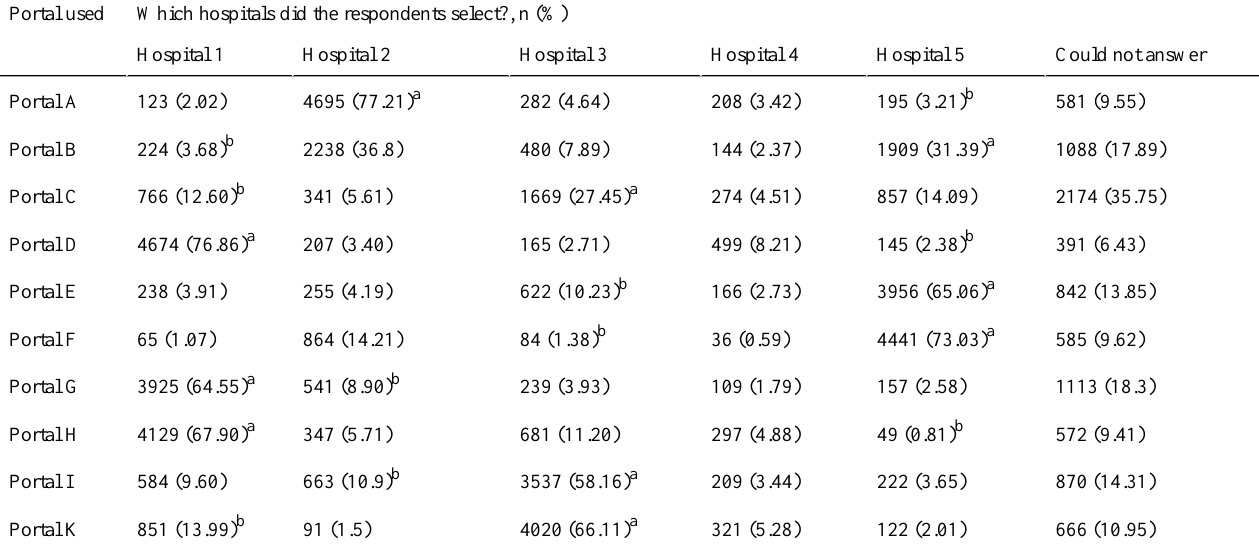
Table 4. Respondents were asked to select the best quality hospital: overview of the selected hospitals (N=6081 observations). Which hospitals did the respondents select?, n (%)Portal used